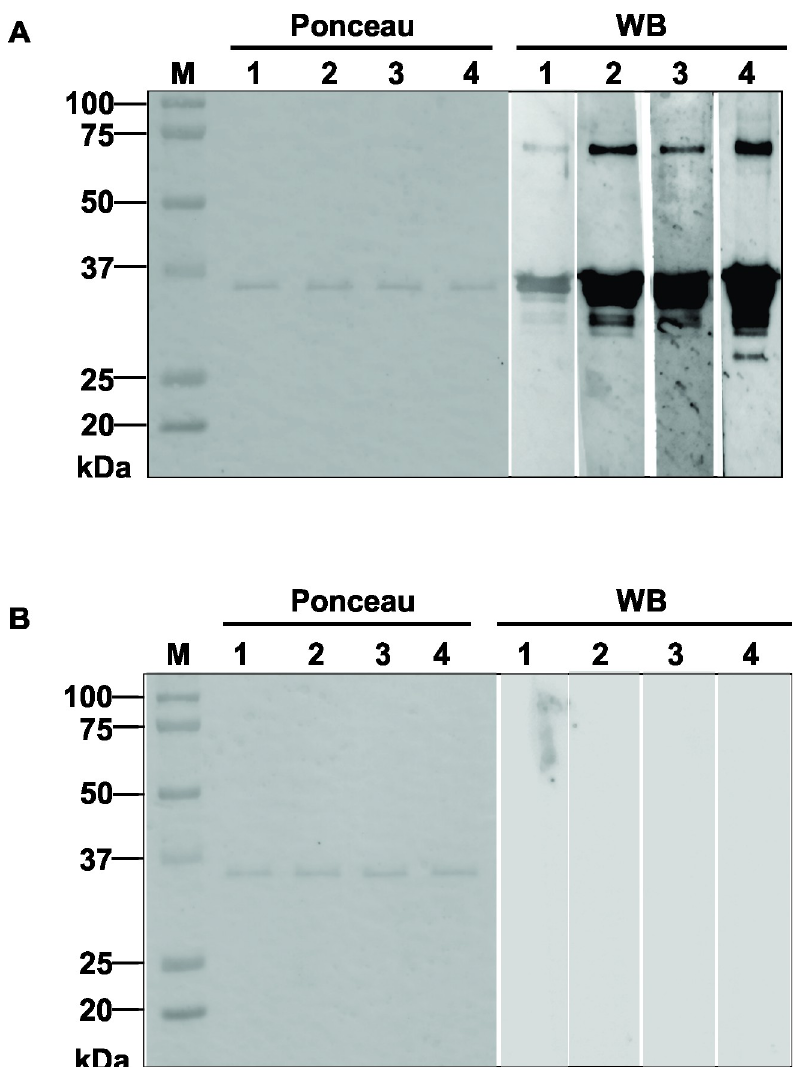
Fig 4. N122-419 is immunoreactive in Western blotting. N122-419 was subjected to SDS-PAGE, transferred to nitrocellulose membrane and to Western blotting using positive (A), and negative sera (B) for